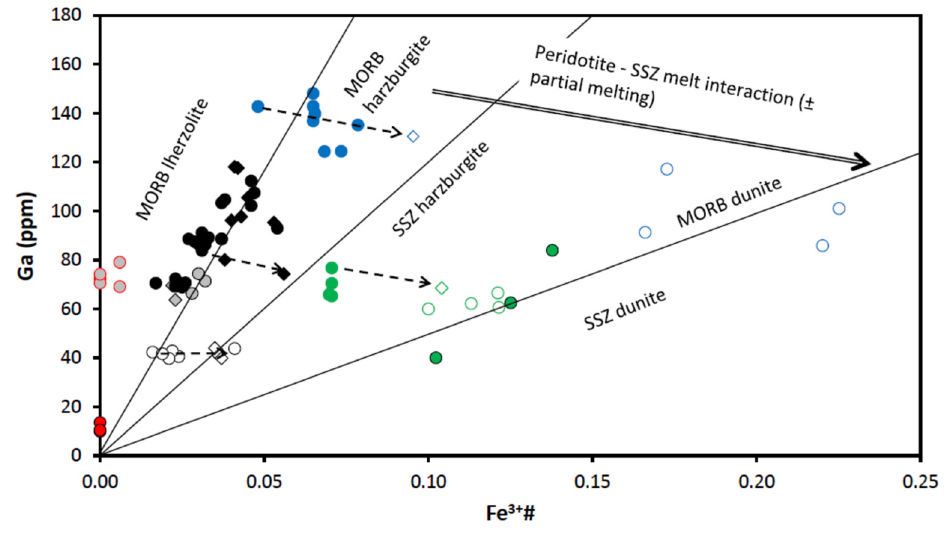
Figure 14. Diagram Fe 3+ # vs. Ga (ppm) for spinels from the East Antarctic peridotite xenoliths. Fields for mid-ocean ridge basalt (MORB) lherzolite, MORB harzburgite, MORB dunite, suprasubduction zone (SSZ) harzburgite and SSZ dunite and “Peridotite–SSZ melt interaction“ trend are after [27,28]. Symbols are as in Figure 9.